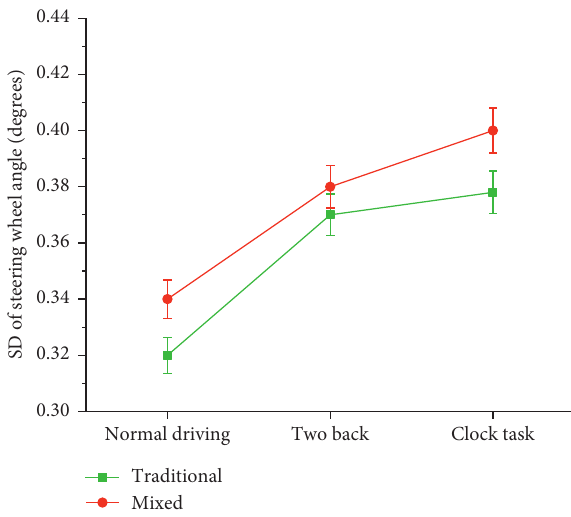
Figure 16: Interaction effect of the driving tasks and environment on the SDSWA.